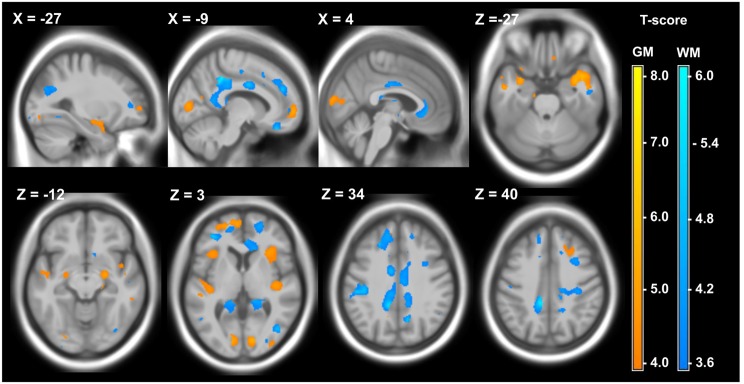
Local atrophy of GM (yellow) and WM (blue) in 12 DM1 patients compared to 28 healthy controls.Voxelwise multiple regression analysis with group and age as covariates. Age was used as a covariate of no interest. Areas with adjusted p at cluster level < 0.05 after FWE correction are shown; X,Y,Z: MNI-coordinates: negative X-values reflect left side and positive X-values right sided location.